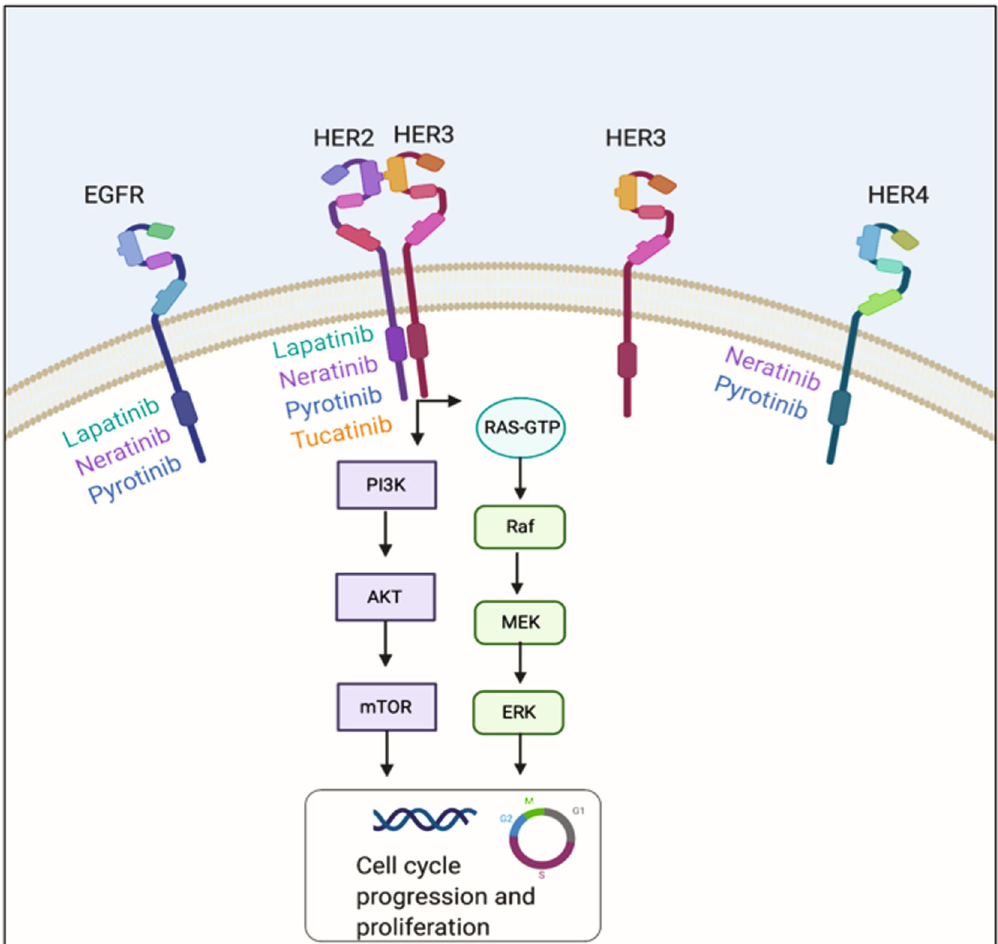
Fig. 1 Mechanism of action of HER2 tyrosine kinase inhibitors. There are four members of the HER2 receptor family, these are the targets of lapatinib, neratinib, pyrotinib and tucatinib. The HER2 extracellular domain has no known ligand and is activated by the formation of homo or heterodimers (exempli fi ed by a HER2-HER3 heterodimer in the fi gure). These dimers lead to phosphorylation of tyrosine kinase residues in the cytoplasmic domain which function as docking sites for proteins that activate the PI3K and MAPK signaling pathways downstream leading to cell cycle progression and